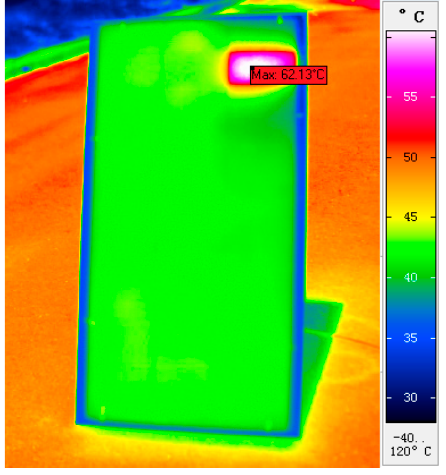
Figure 8. Infrared thermal image of photovoltaic panel with hot spot effect.